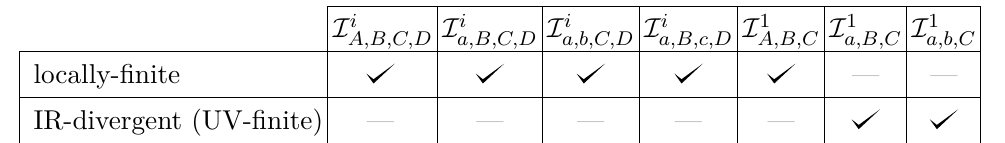
. All these integrals are pure and ⊂ B (4) 3 2